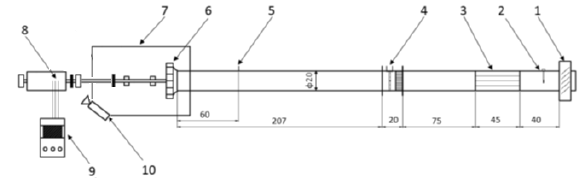
Fig. 5. Test bench for fan balance testing at the AGH Chair of Heat Engines and Turbomachines